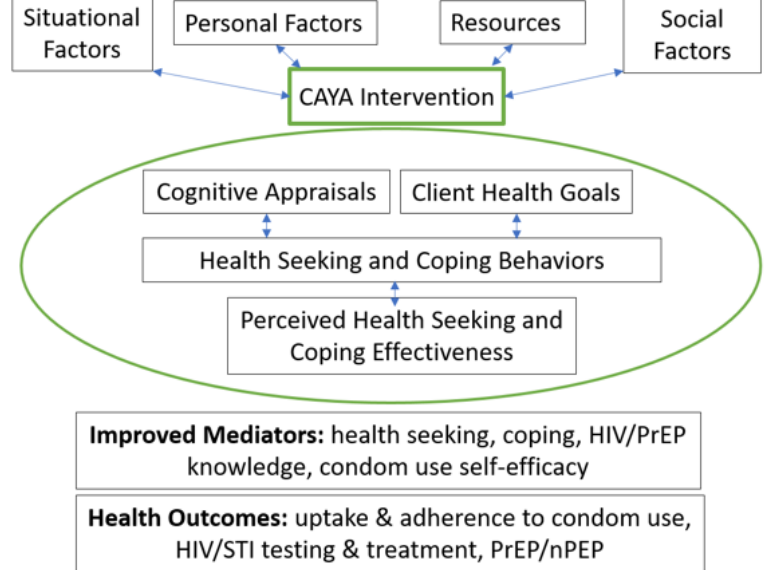
Figure 2. Motivational interviewing enhanced case management. CAYA: Come As You Are; HIV: human immunodeficiency virus; PrEP: preexposure prophylaxis; nPEP: nonoccupational postexposure prophylaxis; STI: sexually transmitted